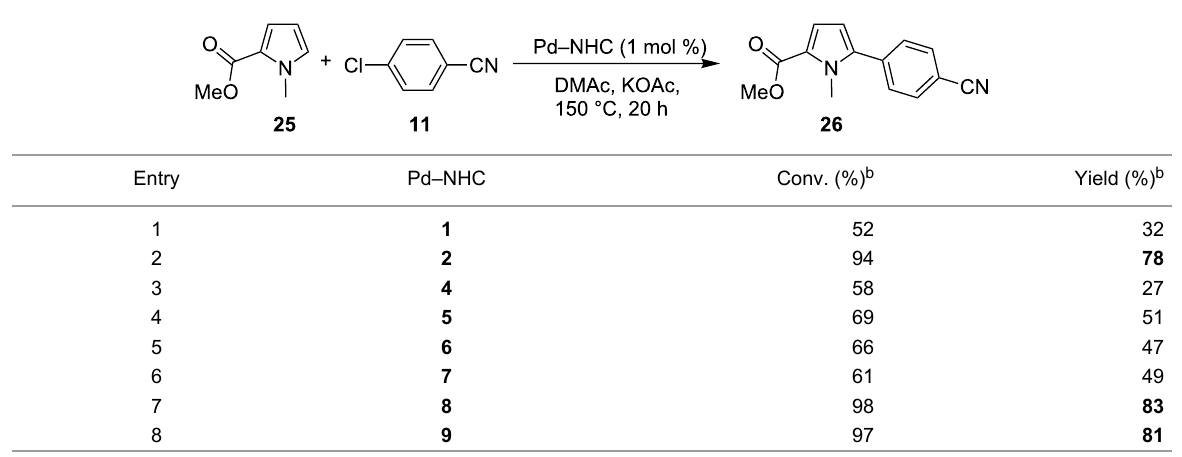
Table 3: Direct arylation of methyl 1-methylpyrrole-2-carboxylate ( 25 ) with 4-chlorobenzonitrile ( 11 ).